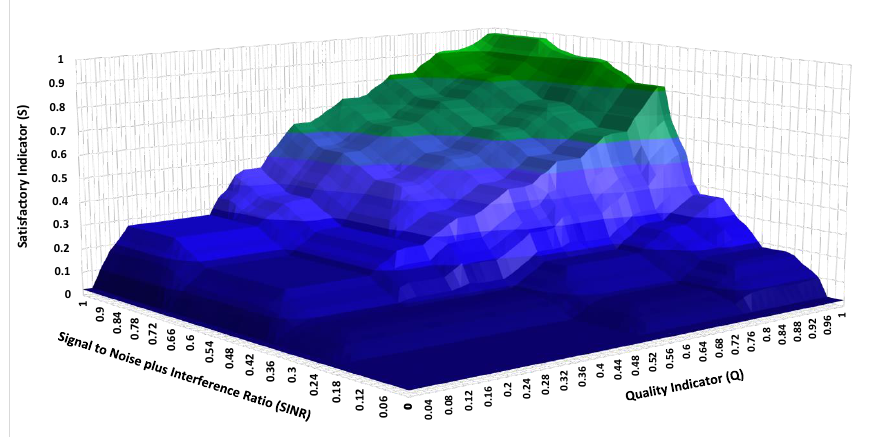
Figure 7. The S values range as obtained using the